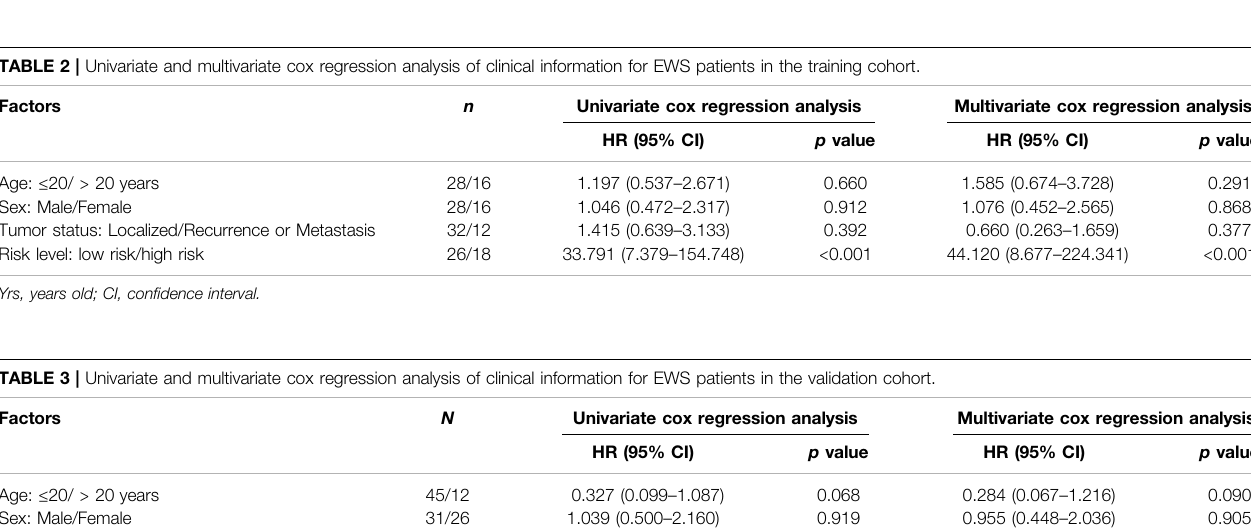
FIGURE 4 | Validation of the risk model in the ICGC cohort. (A) Distribution of EWS patients in ICGC cohort based on the risk score formula. (B) Survival status of each EWS patient. (C) Heatmap of 4 HRGs expressions in two risk groups. (D) KM curves for comparison of the overall survival in two risk groups. (E) ROC curves showed the predictive ef fi ciency of the risk model.